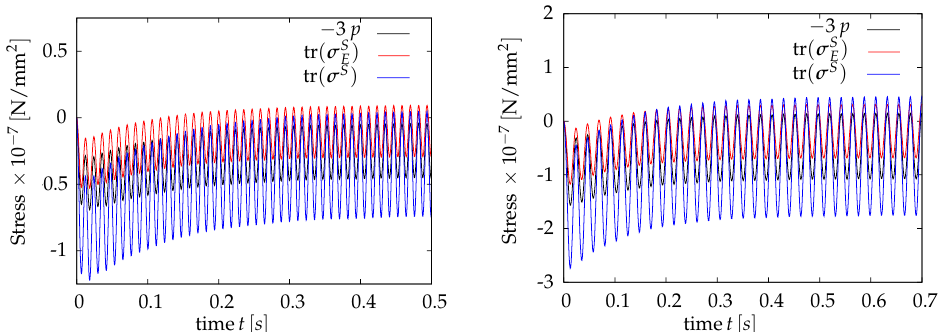
Figure 10. Total solid stress, effective solid stress, and pore-pressure changes over the time range [ 0, 0.5 ] s at point A for the case of an excitation frequency f exc =85Hz ( left ) and over the time range [ 0, 0.7 ] s for f exc =44Hz ( right ).